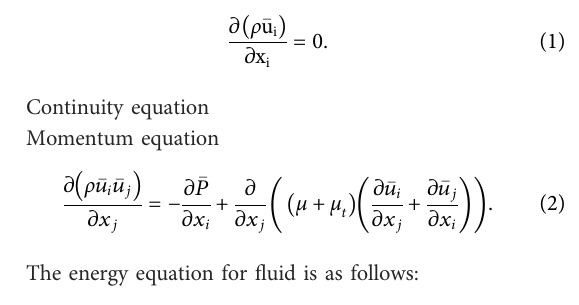
Figure 5 shows the proven tip for veri fi cation of heat transfer characteristics, Figure 5B, a schematic diagram of the blade tip hole, and the distance between the middle arc fi lm holes is shown in 5D. Ignoring the in fl uence of compressibility on heat transfer performance, the heat transfer coef fi cient h and cooling ef fi ciency at the top of the blade tip rib and the bottom of the groove are calculated and are compared with the plane tip test measured by Kwak under subsonic conditions. In Figure 6, all turbulence models overestimate the h value on the tip surface, especially at the top of the groove rib and near the trailing edge, the predicted results of the k- ε model have the biggest gap with the experimental results, and the range of z1 with high leading edge h is the largest; the high position z3 of the SST turbulence model h is close to the middle of the blade, and the range is the smallest, which is closest to the experimental value. Thus, the k- ω SST model is considered decently acceptable.